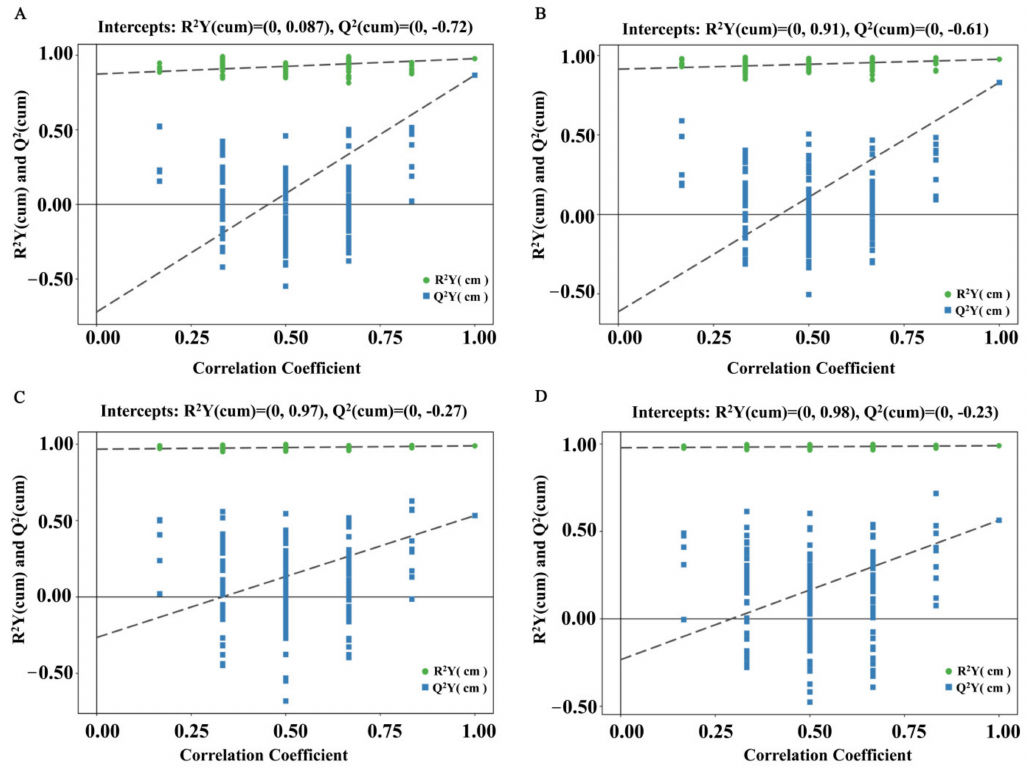
Figure 2. Permutation test displaying the stability of the OPLS-DA model. ( A ) HF versus CT in the ESI+ mode. ( B ) HF versus CT in the ESI- mode. ( C ) HF4H versus HF in the ESI+ mode. ( D ) HF4H versus HF in the ESI-